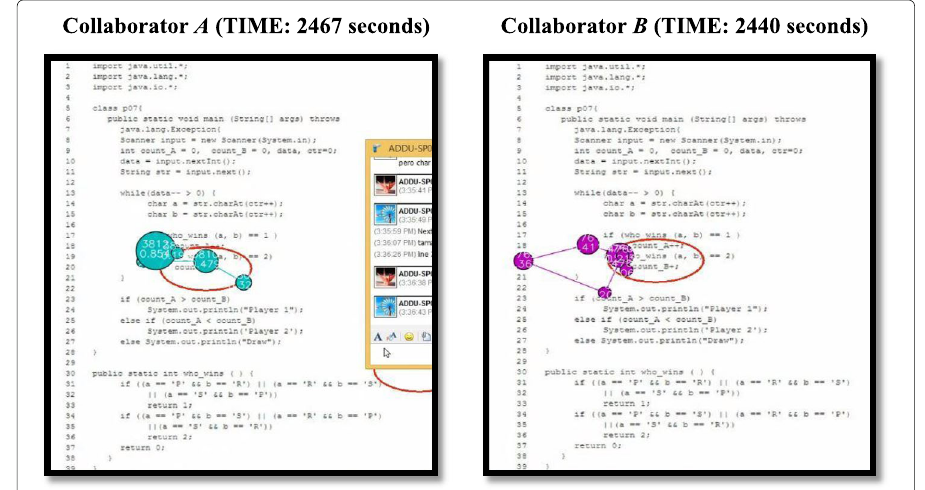
Fig. 3 Snapshots of the fixation locations of the two collaborators subplot) and fixation y -coordinates (bottom subplot) of the two collaborators with the aqua and purple line graphs referring to the first and second collaborators, respectively. The x -axes represent the combined timelines of the two collaborators, while the y -axes denote the valid range of values for the fixations, which is between 0 and 1 in reverse order. The fixations of collaborator A that occurred after 2467 s can be found in the portion enclosed by the blue circles, while the fixations of collaborator B that occurred after 2440 s are bounded by the red circles in the figure. The positions of these fixation x - and y -coordinates, which is at about 0.5, suggest that the fixations points of the two collaborators are